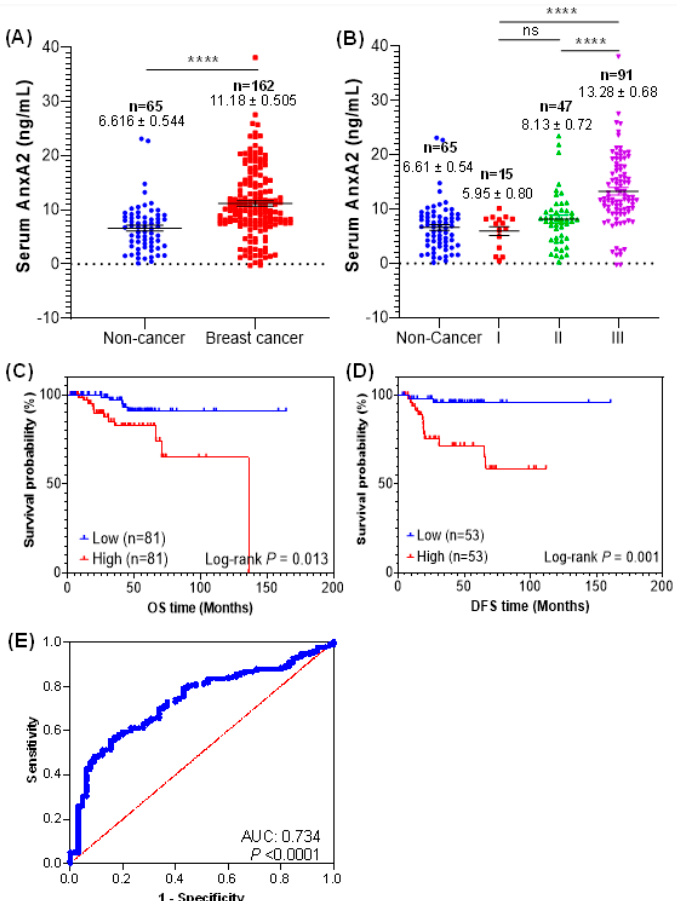
Figure 2. Serum AnxA2 levels in breast cancer patients. ( A ) Serum AnxA2 protein levels in breast cancer patients ( n = 162) and normal healthy females ( n = 65) were determined by ELISA. The data are presented as the mean ± SEM (****, p < 0.0001; two-tailed Students t- test). ( B ) Serum AnxA2 levels in different grades of breast cancer patients (Grade I, n = 15; grade II, n = 47; and grade III, n = 91). The data are presented as the mean ± SEM ( ns , non-significant; ****, p < 0.0001; one-way ANOVA followed by Tukey multiple comparison test). Overall survival ( C ) and diseases-free survival ( D ) of breast cancer patients with high and low serum AnxA2 levels. The p value was calculated using the log-rank test. ( E ) ROC curve for breast cancer patients ( n = 162) versus normal healthy females ( n = 65). Table 2. The association of serum AnxA2 levels with clinicopathological characteristics in breast cancer patients. Serum AnxA2 Levels Pathological Factors Cases ( n )